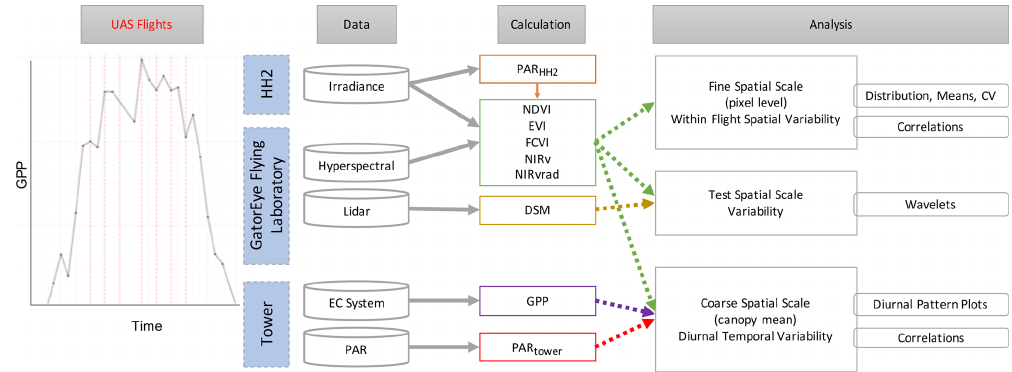
Figure 1. Summary of methods. Diagram representing discrete flight times for UAS and near-continuous EC-estimated GPP (far left). Plat- forms and instrumentation (blue) consisted of the Malvern Panalytical HandHeld 2 Pro spectroradiometer (HH2), the GatorEye Unmanned Flying Laboratory, and the tower at Barro Colorado Island (BCI). Data collected included irradiance, hyperspectral, lidar, eddy covariance system (EC), and photosynthetically active radiation (PAR). Calculations made were PAR with the HH2 (PARHH2), normalized difference vegetation index (NDVI), enhanced vegetation index (EVI), fluorescence correction vegetation index (FCVI), the near-infrared vegetation index (NIRv), the near-infrared radiance of vegetation (NIRvrad), the digital surface model (DSM), gross primary productivity (GPP), and PAR from the PAR sensor on the tower (PARtower). An overview of the data analysis at each scale is provided in the right of the diagram.